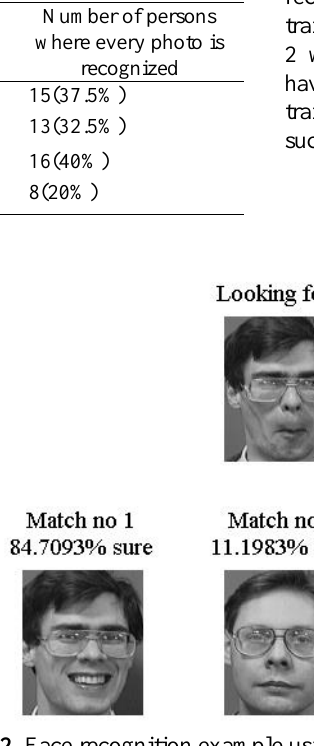
Table 2. Comparison of neural network performance using